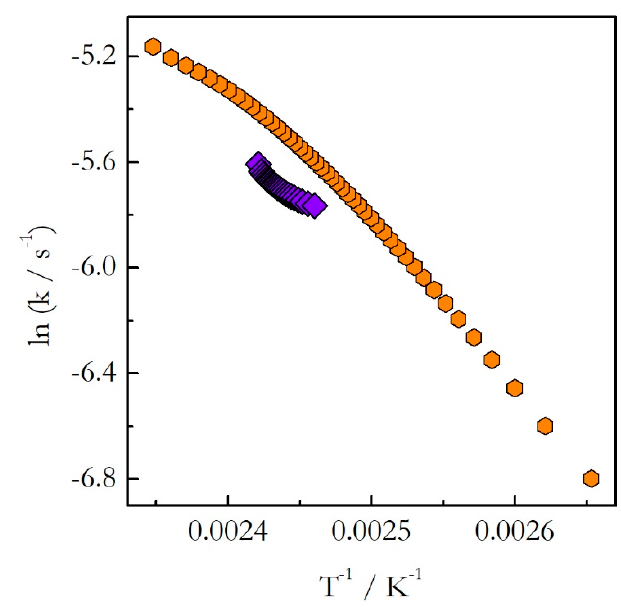
Figure 7. The rate constant as a function of reciprocal temperature for the stoichiometric polymerization of DGEBA and m-PDA evaluated on heating (orange hexagons) and cooling (violet diamonds) [23]. Adapted from Ref. [23] with permission from Elsevier.